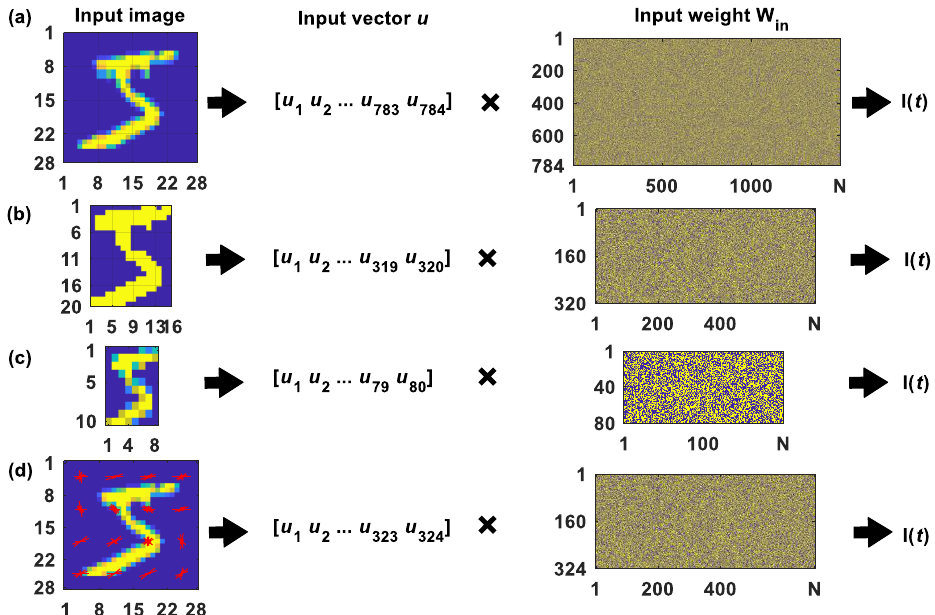
Figure 2. Schematic diagram of the preprocessing procedure. ( a ) Input full image; ( b ) Input trimmed image; ( c ) Input 2 × -downscaled features, ( d ) Input HOG features.